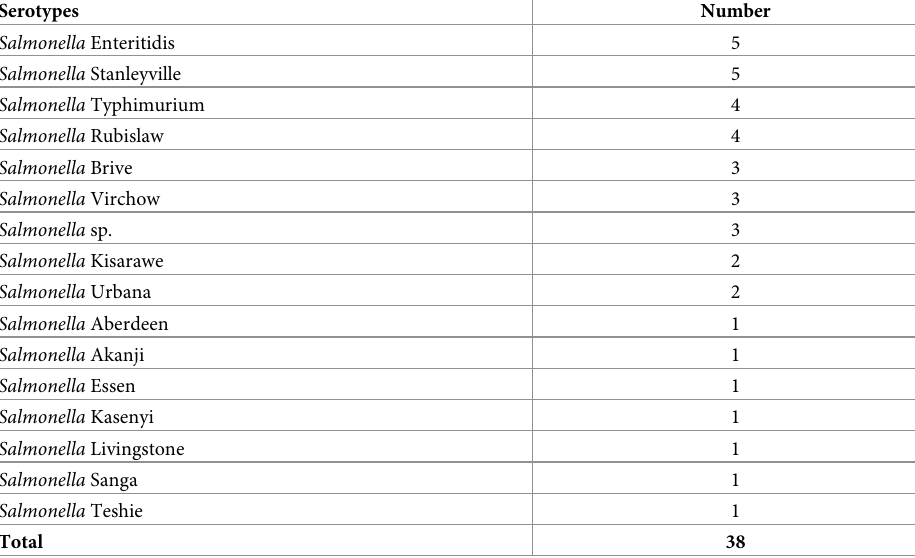
Table 2. Distribution of Salmonella isolates according to